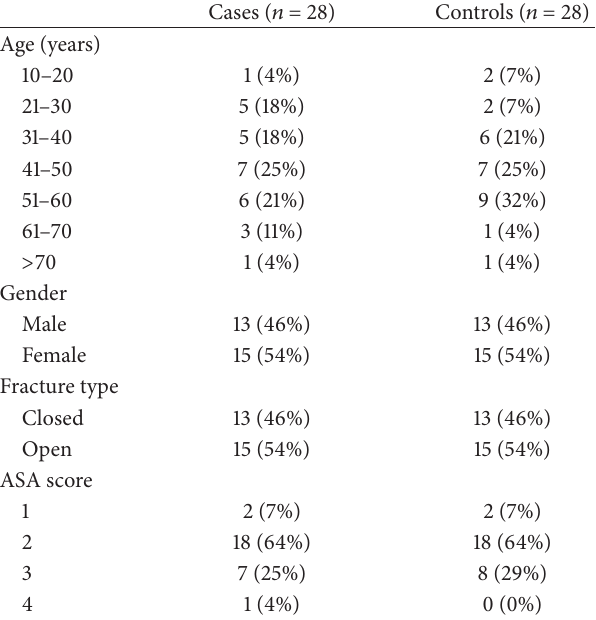
Table 1: Selected demographics for cases and